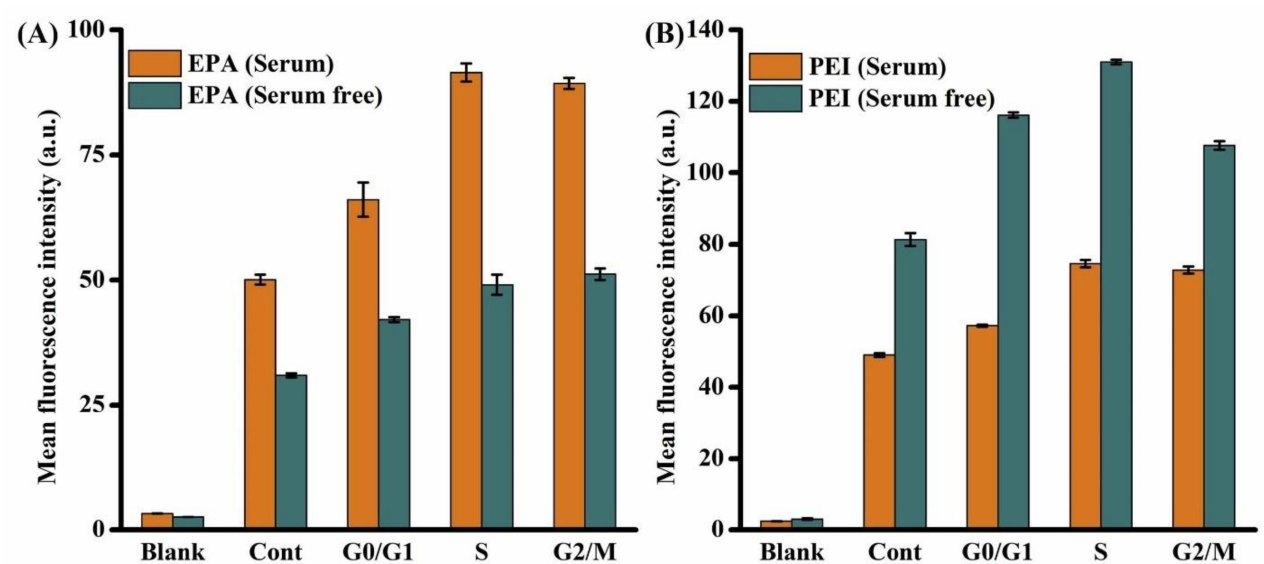
Figure 16. Intracellular uptake of EPA-CQDs ( A ) and PEI-CQDs ( B ) by normal HeLa cells (Cont) and by cells at three cell cycle phases (G0/G1, S, and G2/M), cultured in media with and without serum. Reprinted from ref. [222], with permission from